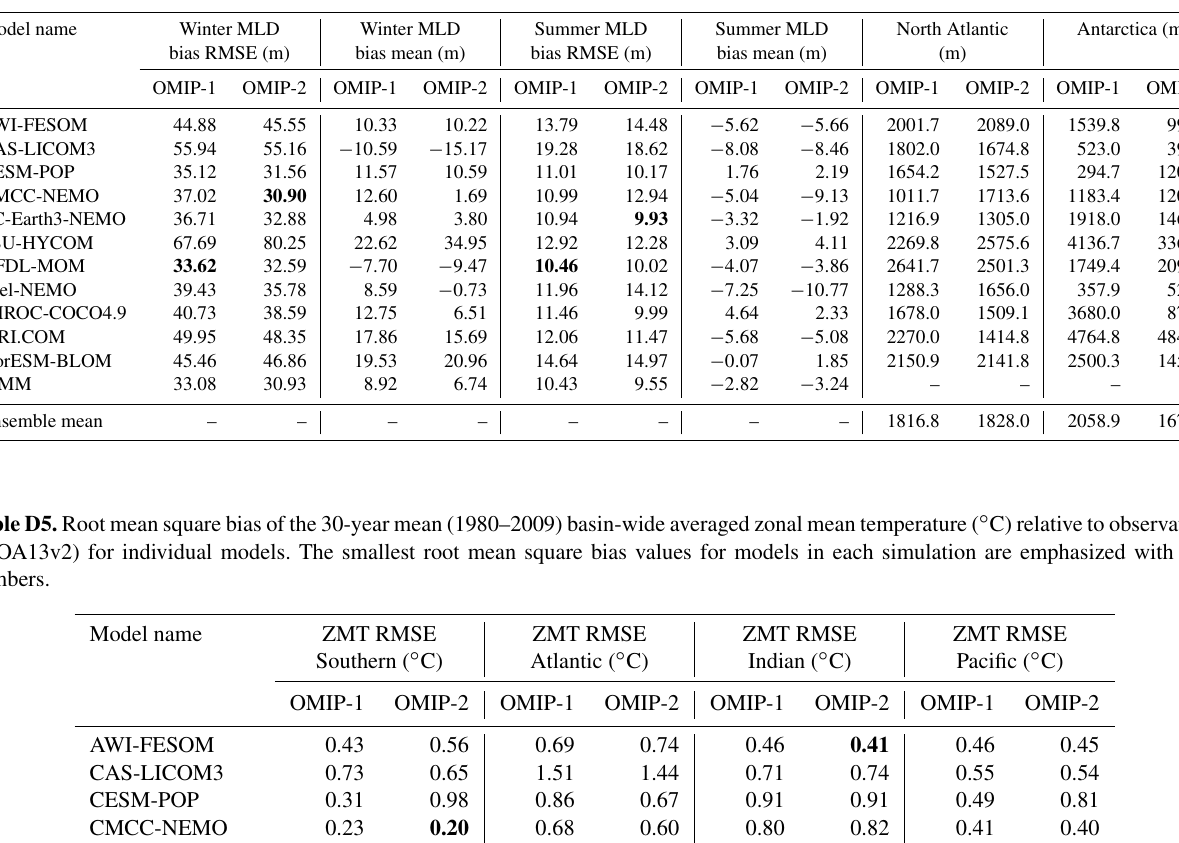
Table D4. Root mean square bias and mean bias of the 30-year mean (1980–2009) mixed layer depth (m) relative to observationally derived mixed layer depth data from de Boyer Montégut et al. (2004) in summer and winter and the maximum depth of the 30-year mean (1980– for individual models. Root mean square bias and mean bias in winter are computed by excluding the above regions of the North Atlantic and the marginal seas around Antarctica. The smallest root mean square bias values for models in each simulation are emphasized with bold numbers.